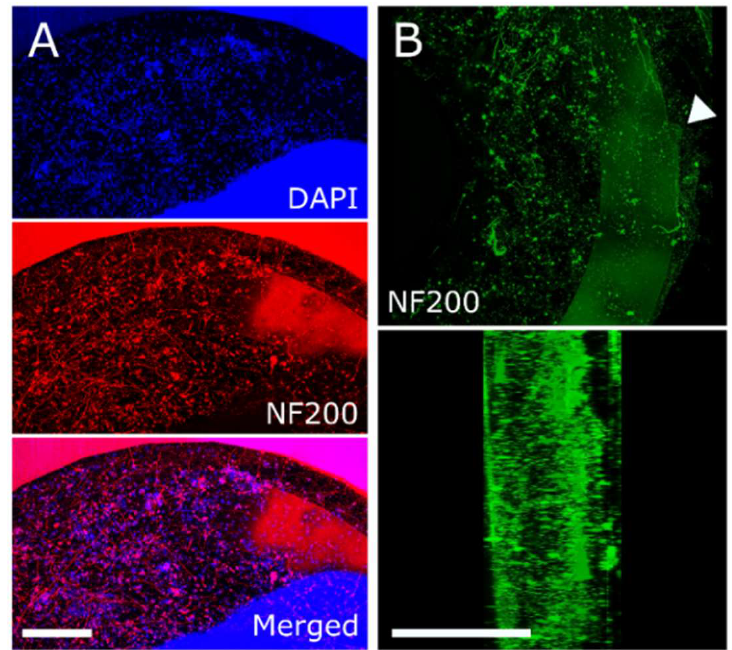
Figure 3. Viable soma and axonal projections present throughout at least 500 µ m of recording volume following 28 DIV, indicated via immunocytochemistry. ( A ) Maximum intensity projection of DAPI (top, cell nuclei) and NF200 (middle, neurons) for the bottom-most 50 µ m relative to the substrate. White arrowhead indicates location of recording electrode. Scale bar represents 100 µ m. ( B ) Volumetric view of 500 µ m section of neuronal culture (top, NF200, green). (Bottom) 90-degree rotated view of axial cross-section. Scale bar represents 500 µ m.